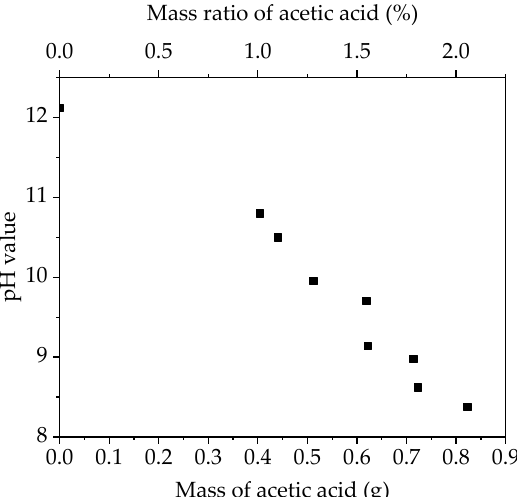
0.0 0.1 0.2 0.3 0.4 0.5 0.6 0.7 0.8 Figure 1. The pH value of slurry as a function of the mass and mass ratio of added acetic acid. Before tape casting, the viscosity of slurries with different pH values was measured at shear rates from 0 to 100 s − 1 . As shown in Figure 2a, slurries with different pH values show similar shear thinning behavior which means that the viscosity decreases with increasing shear rate. This indicates the existence of soft agglomerates within the slurries. With decreasing slurry pH value, a distinct increase of viscosity was found, suggesting that higher shear force is needed to break the agglomerates in slurries with lower pH values. Figure 2b shows the viscosity of slurries with different pH values at a reference shear rate of 50 s − 1 . The functional relationship between viscosity and pH value shows approximately linear correlation. During experiments, it was found that slurries with a viscosity of 3 to 8 Pa · s at 50 s − 1 were beneficial to prepare thick-film electrodes. In general, the manufacturing of thick-film electrodes can be achieved by reducing the solvent (water) content or by increasing the binder content in slurries, which in both cases leads to an increase in